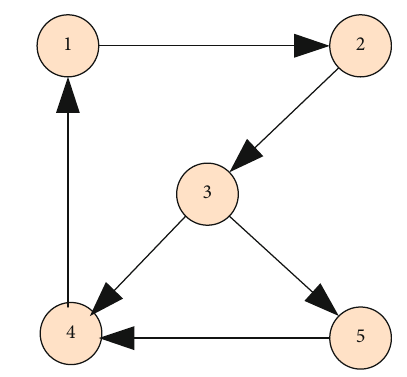
Figure 1: Interaction topology G